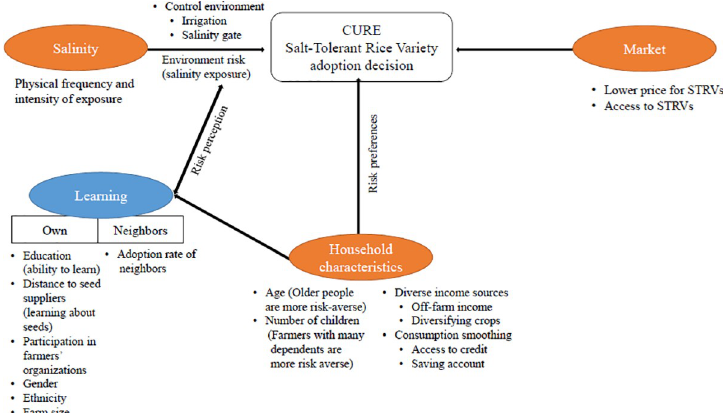
Fig 1. Framework for the farmer salt-tolerant rice variety (STRV) decision. Sources: Boundary of countries: https:// www.naturalearthdata.com/downloads/50m-cultural-vectors/50m-admin-0-countries-2. Boundary of provinces: https://www.naturalearthdata.com/downloads/10m-cultural-vectors/10m-admin-1-states-provinces. Ocean: https:// www.naturalearthdata.com/downloads/10m-physical-vectors/10m-ocean. (January 21, 2020).